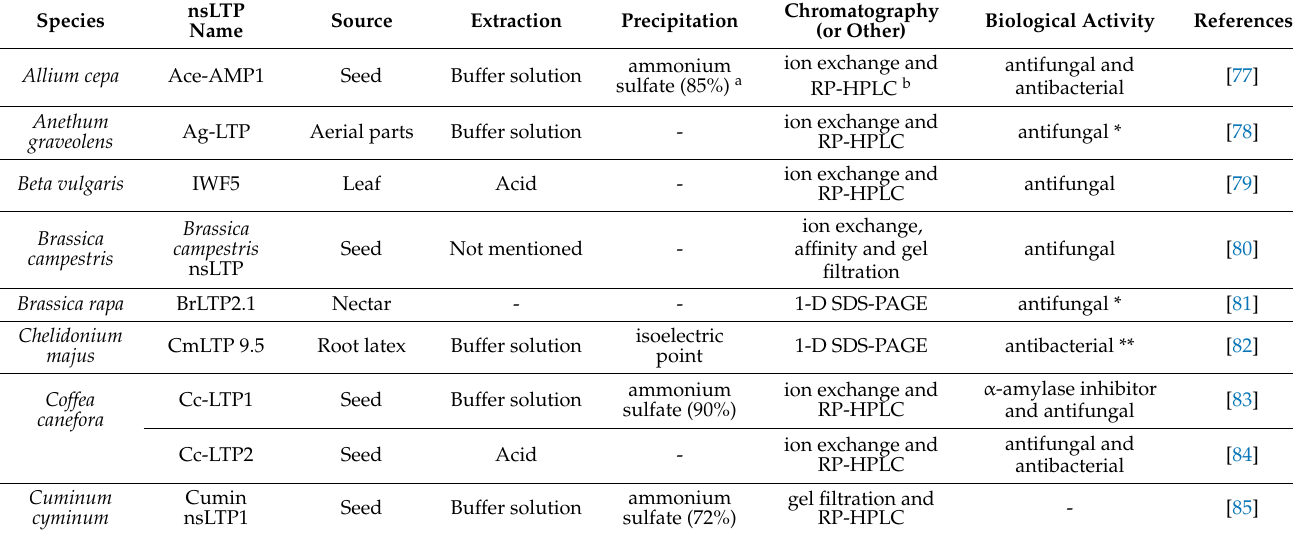
Table 2. Natural occurring nsLTPs identified in plants, including main isolation steps (type of extraction, precipitation and chromatography) as well as recorded biological